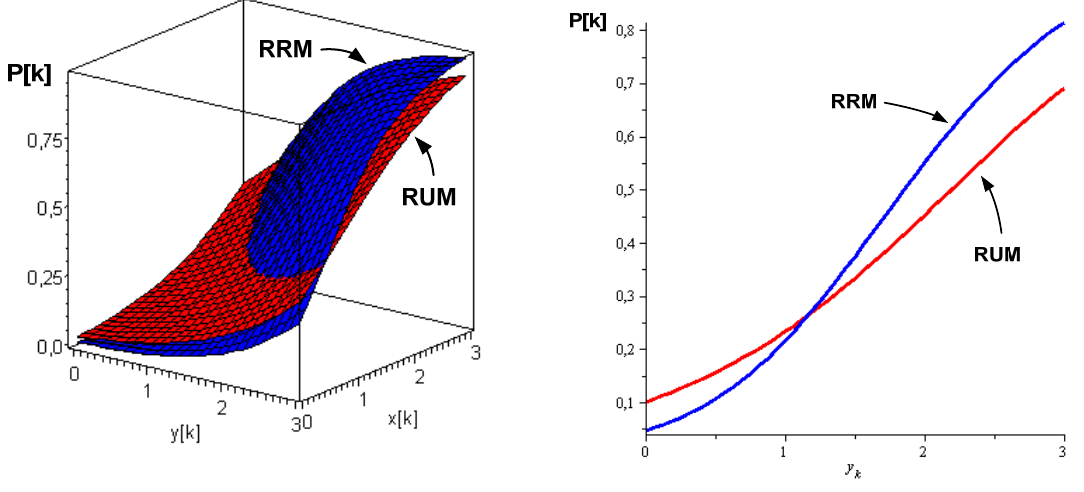
Figure 2. Comparing choice probabilities generated by RRM and